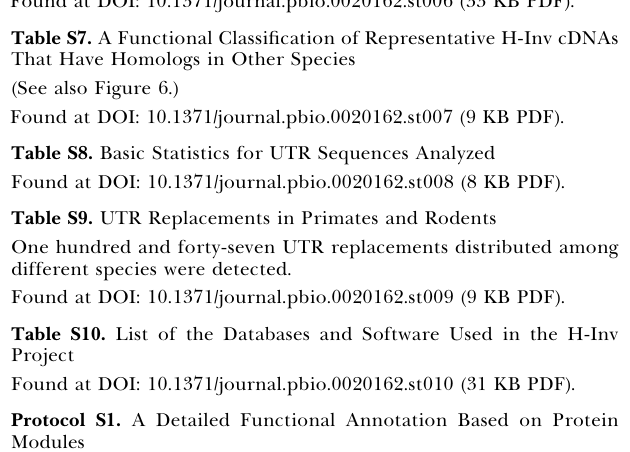
Table S5. GO Term Assignment to H-Inv Proteins